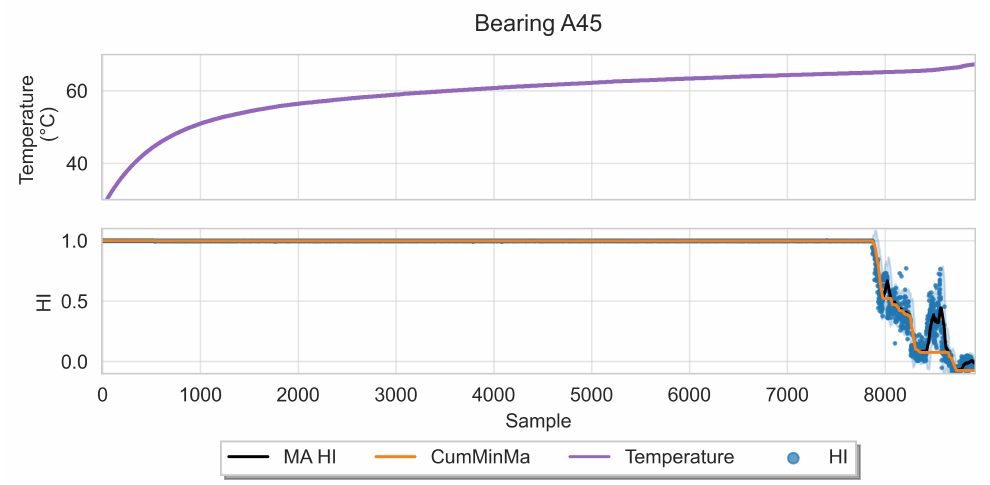
Figure 10. Temperature and HI of bearing A45 of the SMLL dataset. The HI seems to recover over time without it being related to a stop in the